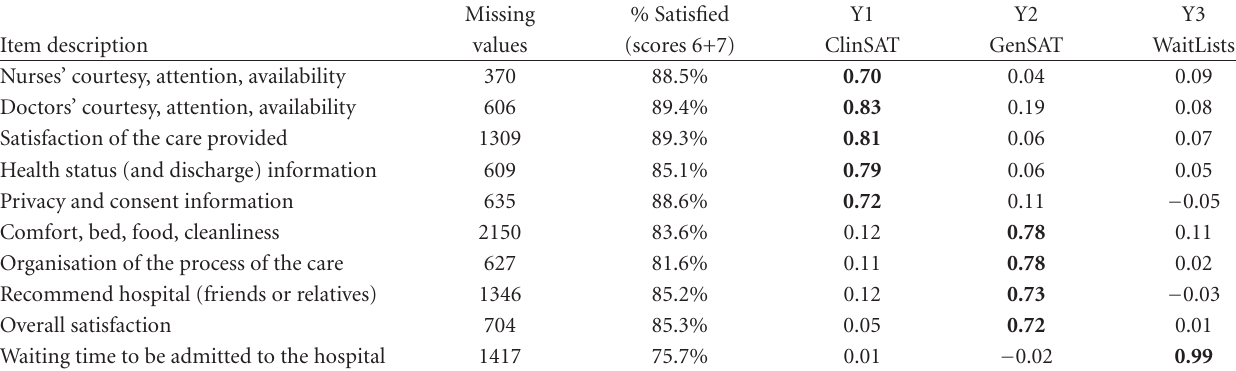
Table 1: Item Analysis: missing values, percentage of patients satisfied, and item-component correlation ( n = 46,096). Missing % Satisfied Y1 Y2